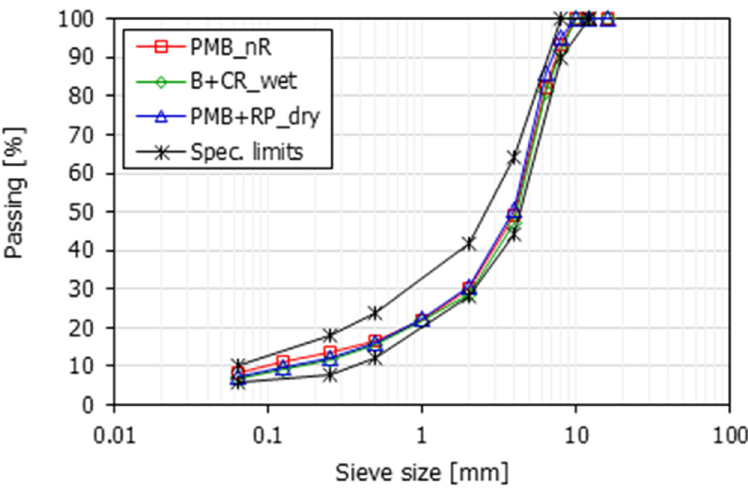
Figure 1. Aggregate gradations.